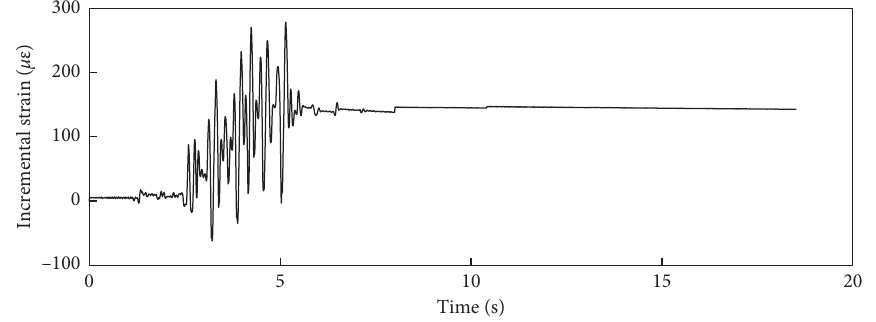
Figure 9: Time history of geogrid strain for specimen 1 under case